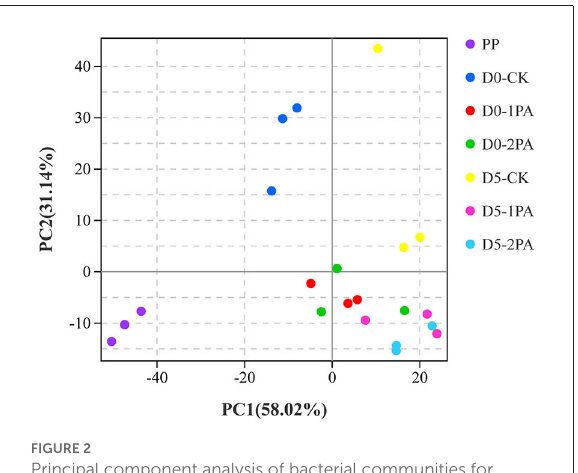
FIGURE2 Principal component analysis of bacterial communities for Napier grass silages treated without or with 1 and 2% pyroligneous acid after 30 days of ensiling and 5 days of exposure to